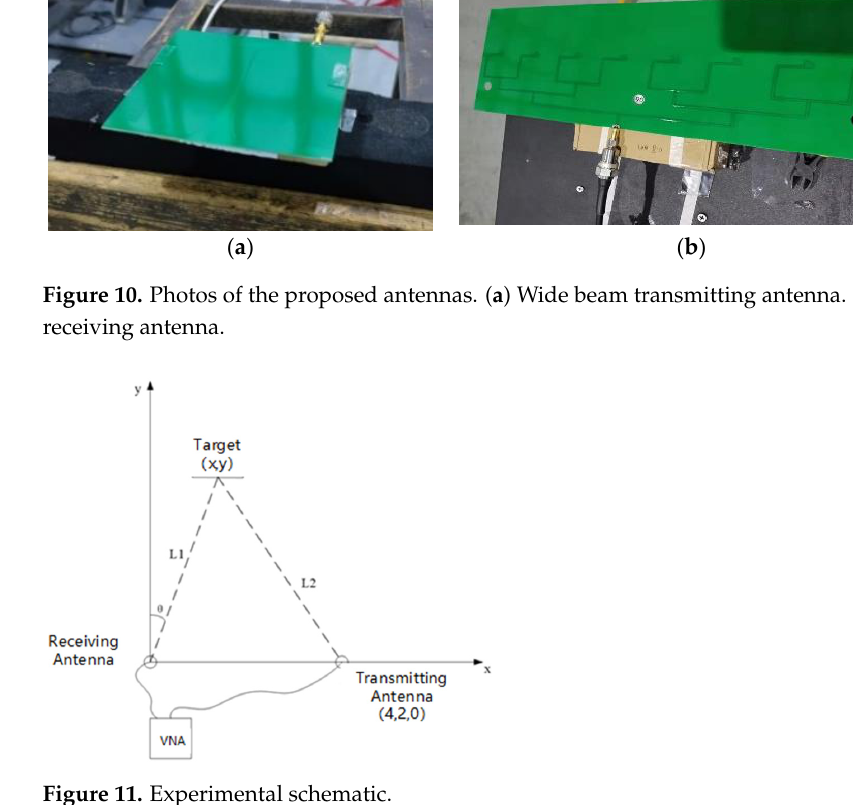
Figure 11. Experimental schematic.